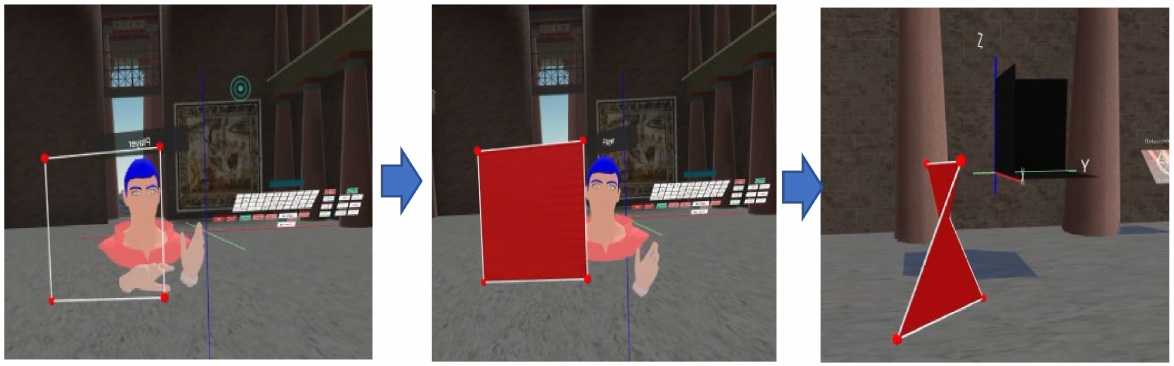
Figure 8. Non-planar